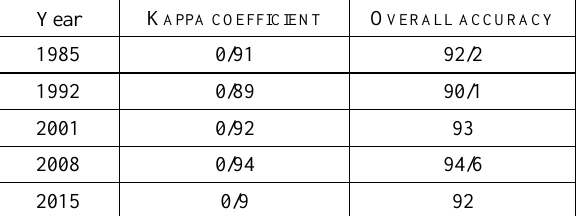
Table 3. Accuracy asssessment results of the produced land use